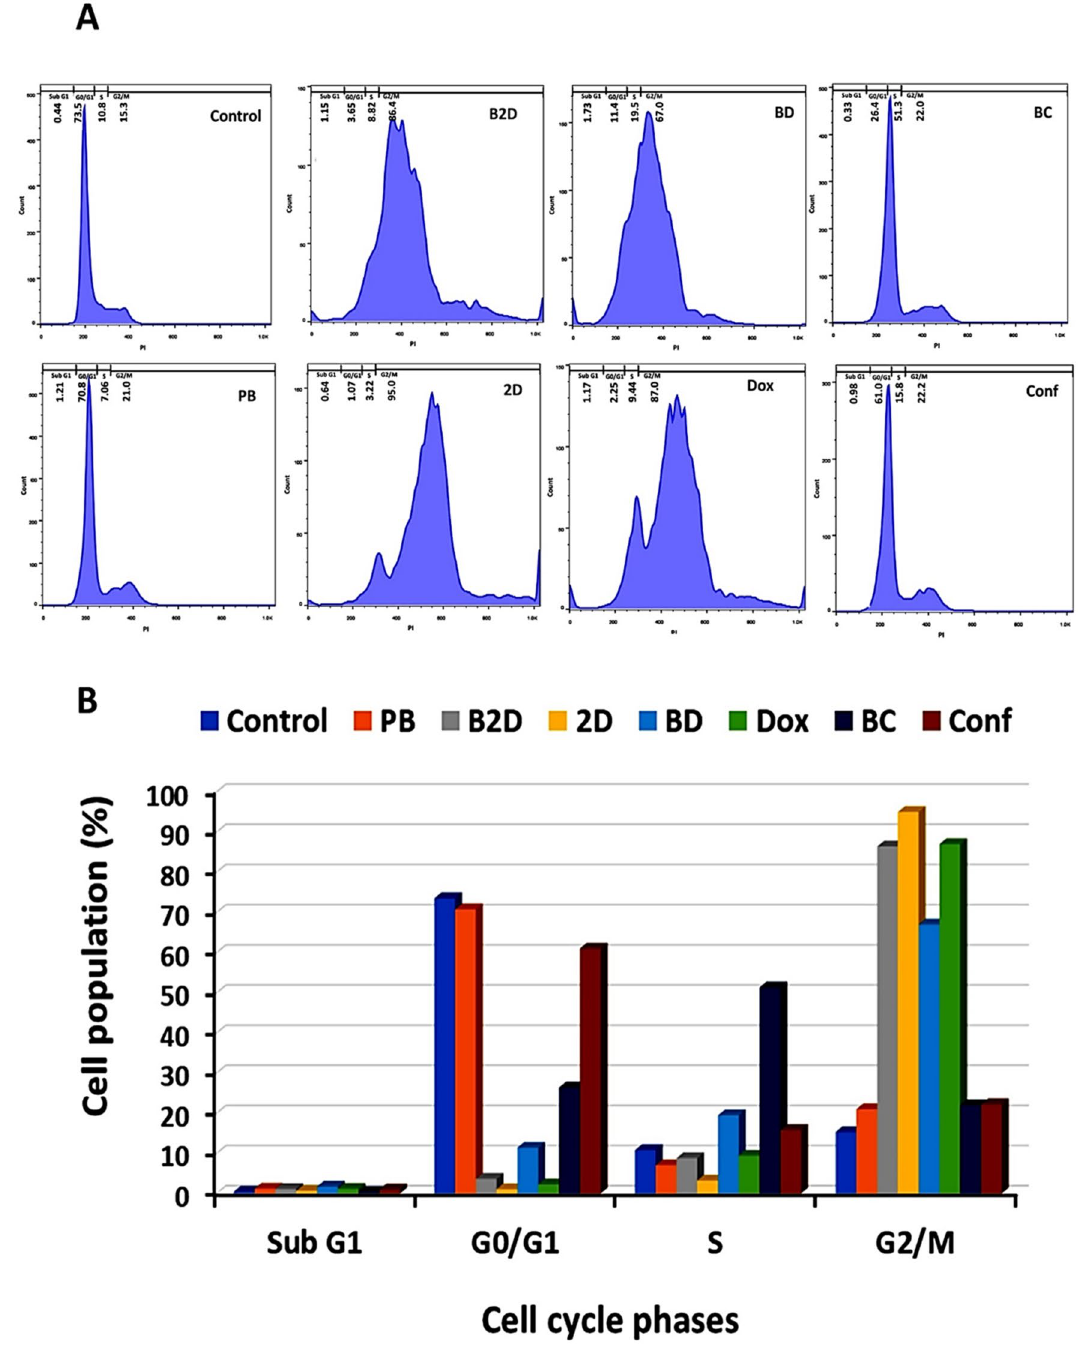
Figure 6. Results of cell cycle test of MDA-MB-231 cells treated with all formulations (0.259 μg/mL of B2D , 2D , BD , Dox , BC and Conf and 2.59 μg/mL of PB ) by flowcytometry method: ( A ) Histograms of cell cycle distrubution and ( B ) Quantitative diagram of cell population (%) in different phases of cell cycle (Sub G1, G0/ G1, S and G2/M), in presence of all formulations (Abbreviations: PB : blank βCD-g-PMA-co-PLGA micelles, B2D : co-drug loaded βCD-g-PMA-co-PLGA micelles, BD : Dox loaded βCD-g-PMA-co-PLGA micelles, BC : Conferone loaded βCD-g-PMA-co-PLGA micelles, Dox : Free Doxorubicin, Conf : Free Conferone, 2D : Free